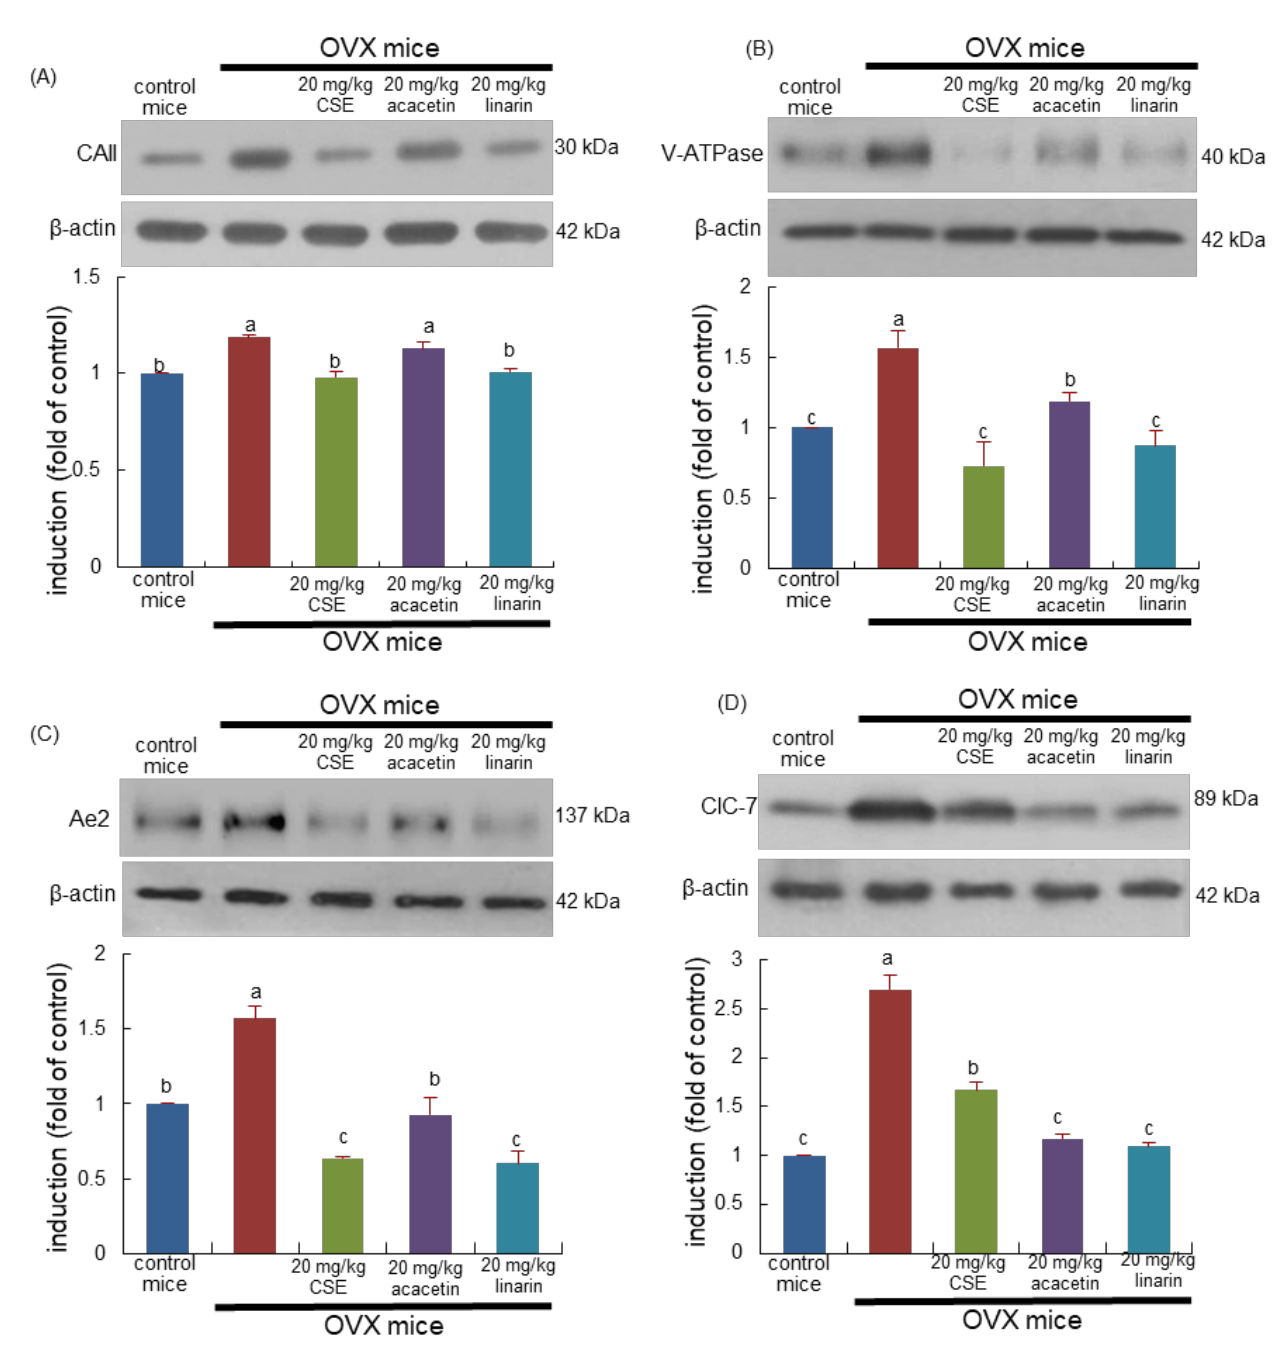
Figure 3. Inhibition of induction of osteoclastic proteins of ovariectomized (OVX) mice induced by Cirsium setidens water extracts (CSEs). OVX mice were orally supplemented with 20 mg/kg CSEs, 20 mg/kg acacetin, or 20 mg/kg linarin daily for 8 weeks. Whole bone tissue extracts were subjected to SDS-PAGE and Western blot analyses with specific antibodies against carbonic anhydrase II (CAII; A ), vacuolar ATPase (V-ATPase; B ), anion exchanger 2 (Ae2; C ), and chloride channel (ClC)-7 ( D ). β -Actin was used as internal control. The bar graphs (mean ± SEM, n = 3) represent quantitative results of bands obtained with a densitometer. Values in bar graphs not sharing a small alphabetical letter at p < 0.05.